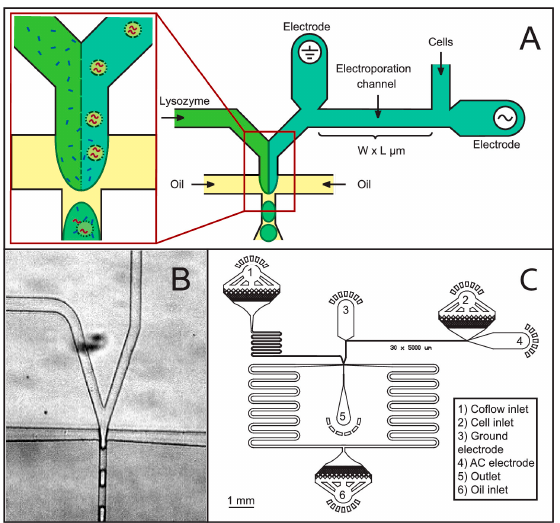
Figure 13. Electrical cell lysis device: ( a ) fabrication protocol of the device; ( b ) working principle of the device; and ( c ) microfluidic device used in the study for lysing red blood cells. Reproduced with permission from [87].